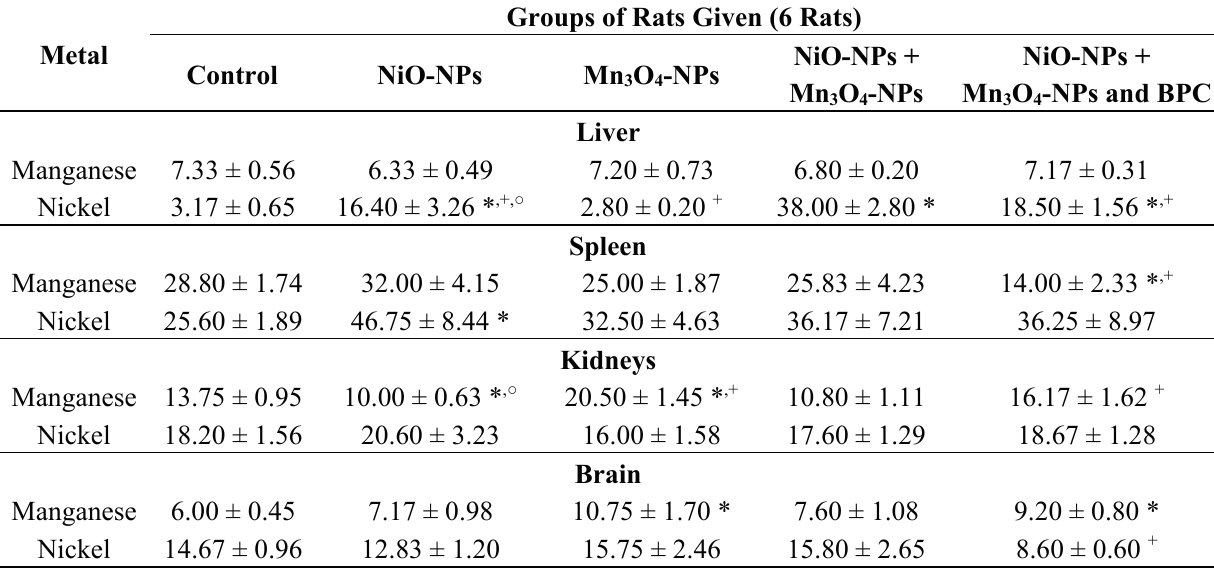
Table 1. Total manganese and nickel contents of rat’s organs, mcg per g of dried tissue, after repeated intraperitoneal injections of NiO or Mn 3 O 4 nanoparticles, together or separately, and of their combination with background oral administration of the BPC (X ±